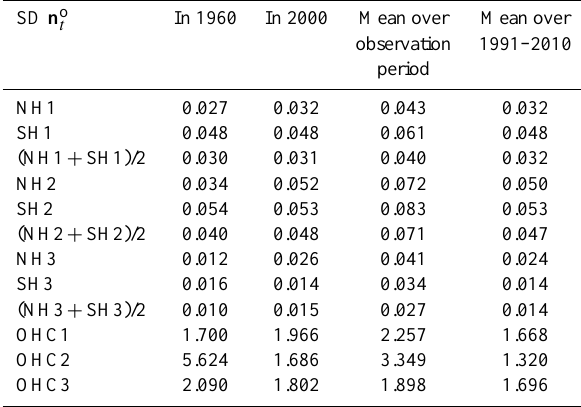
Table A5. Estimates of standard deviations of n o t